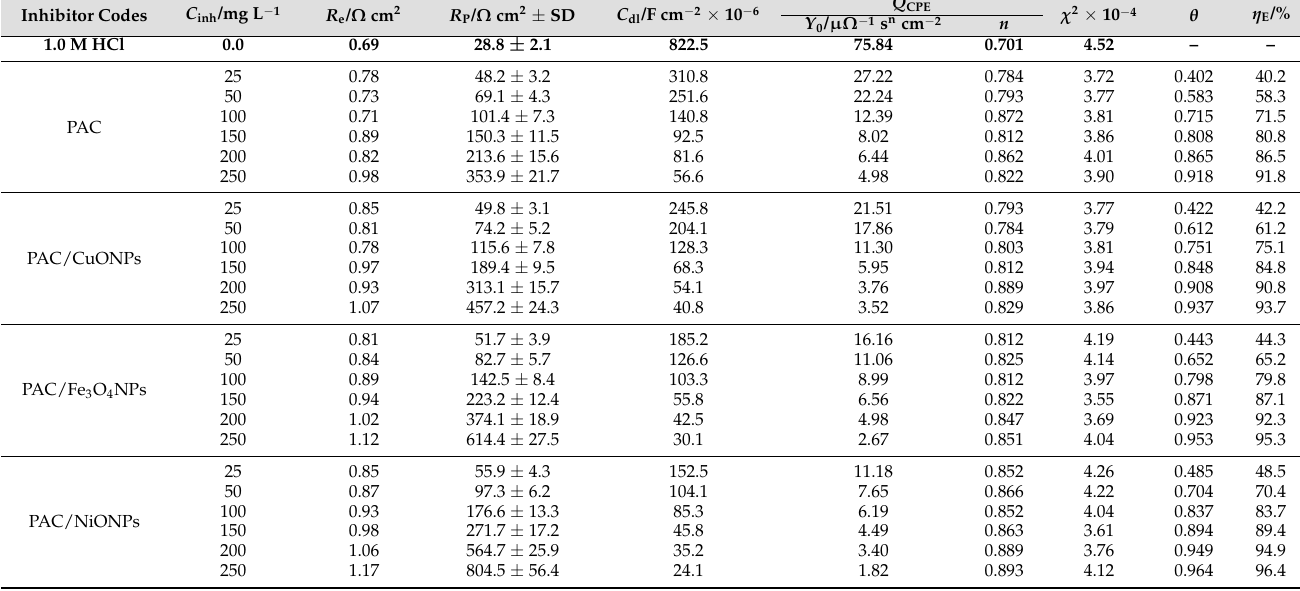
Table 2. Impedance parameters for C-steel in molar hydrochloric acid without and with different concentrations of the as-prepared nanocomposite inhibitors at 50 ◦